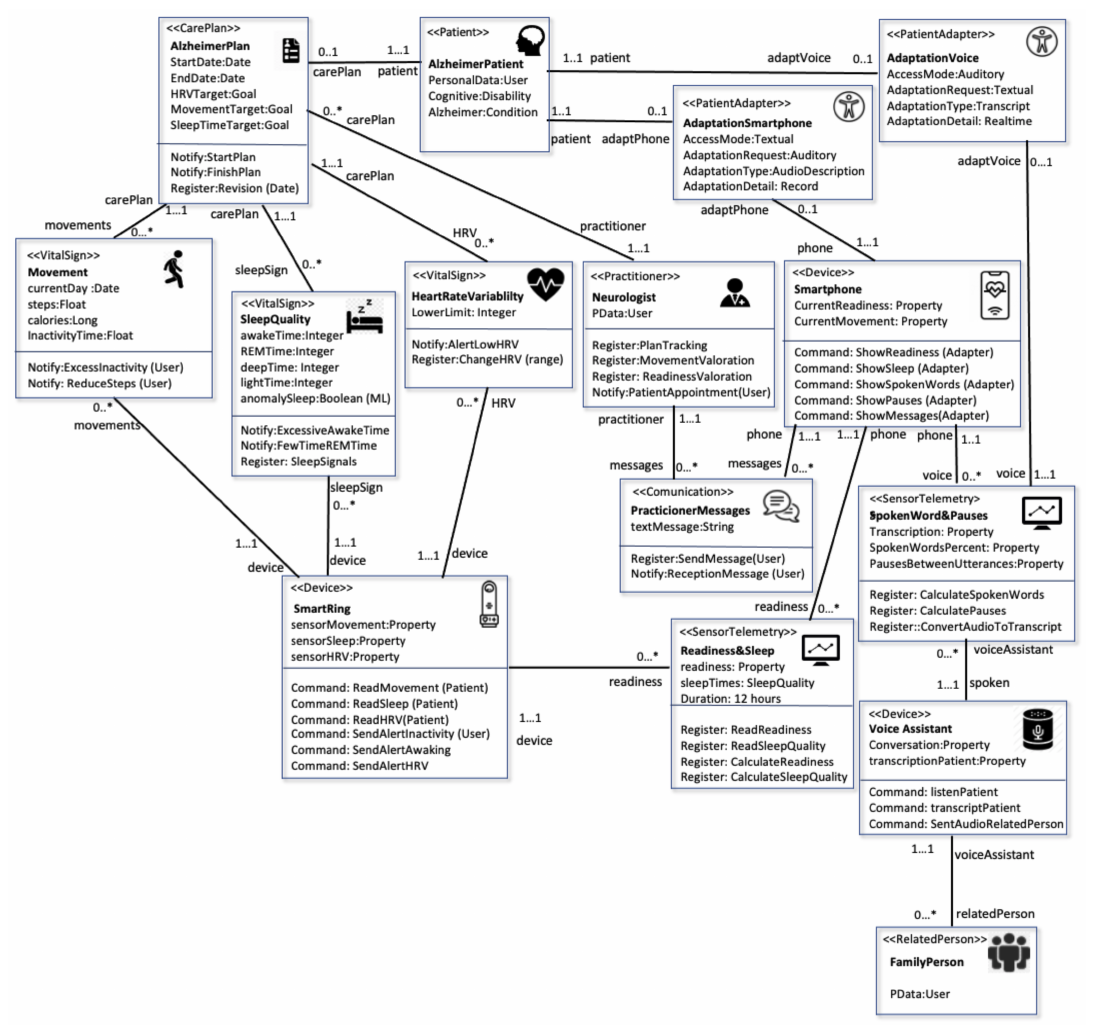
Figure 9. Alzheimer’s scenario using the information